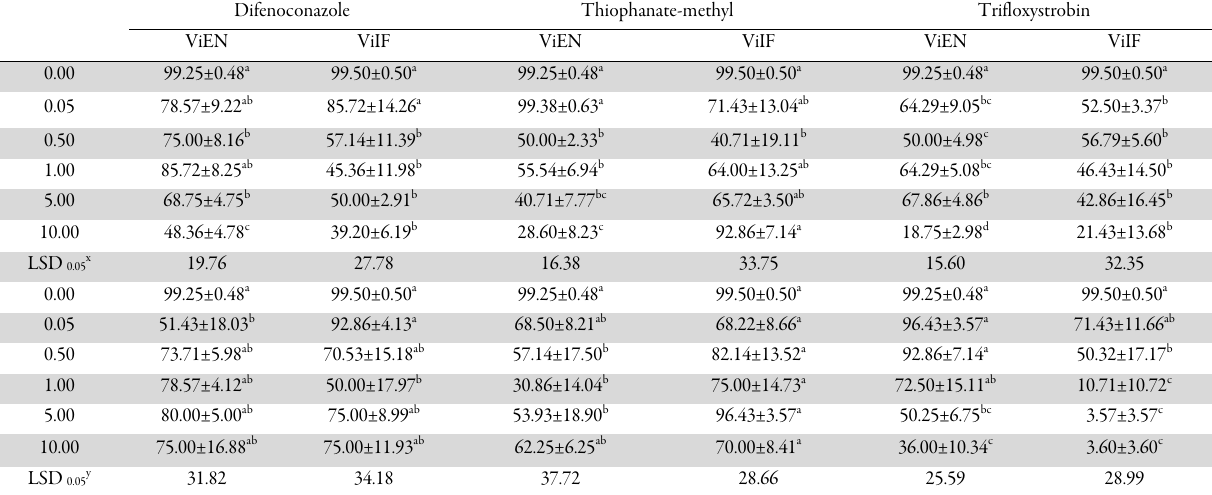
Table 3. Averaged disease severity of the two isolates of V. inaequalis on detached apple leaves (n = 4)